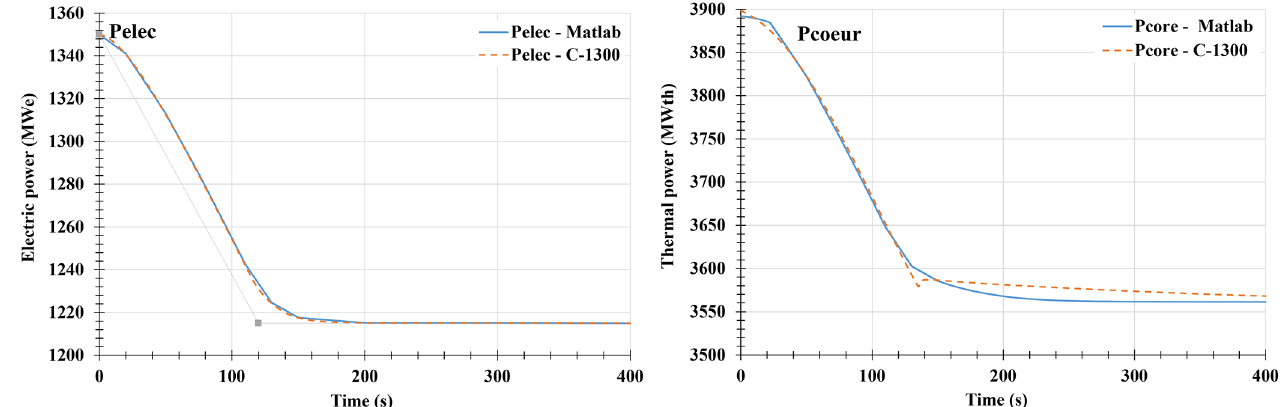
Fig. 8. Electrical and thermal power for the Matlab load-following validation case.